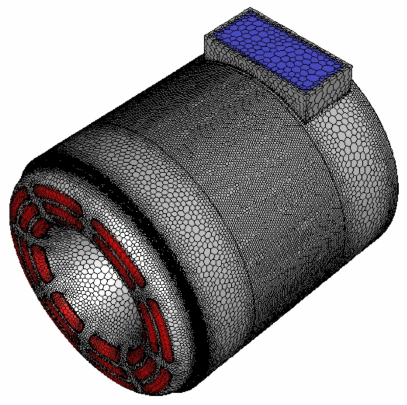
Figure 2. Mesh of solution